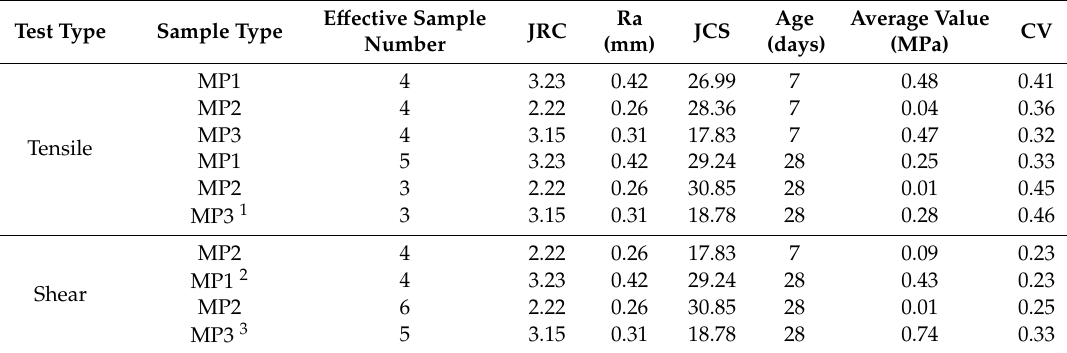
Table 4. Summary of specimen details and tests results.